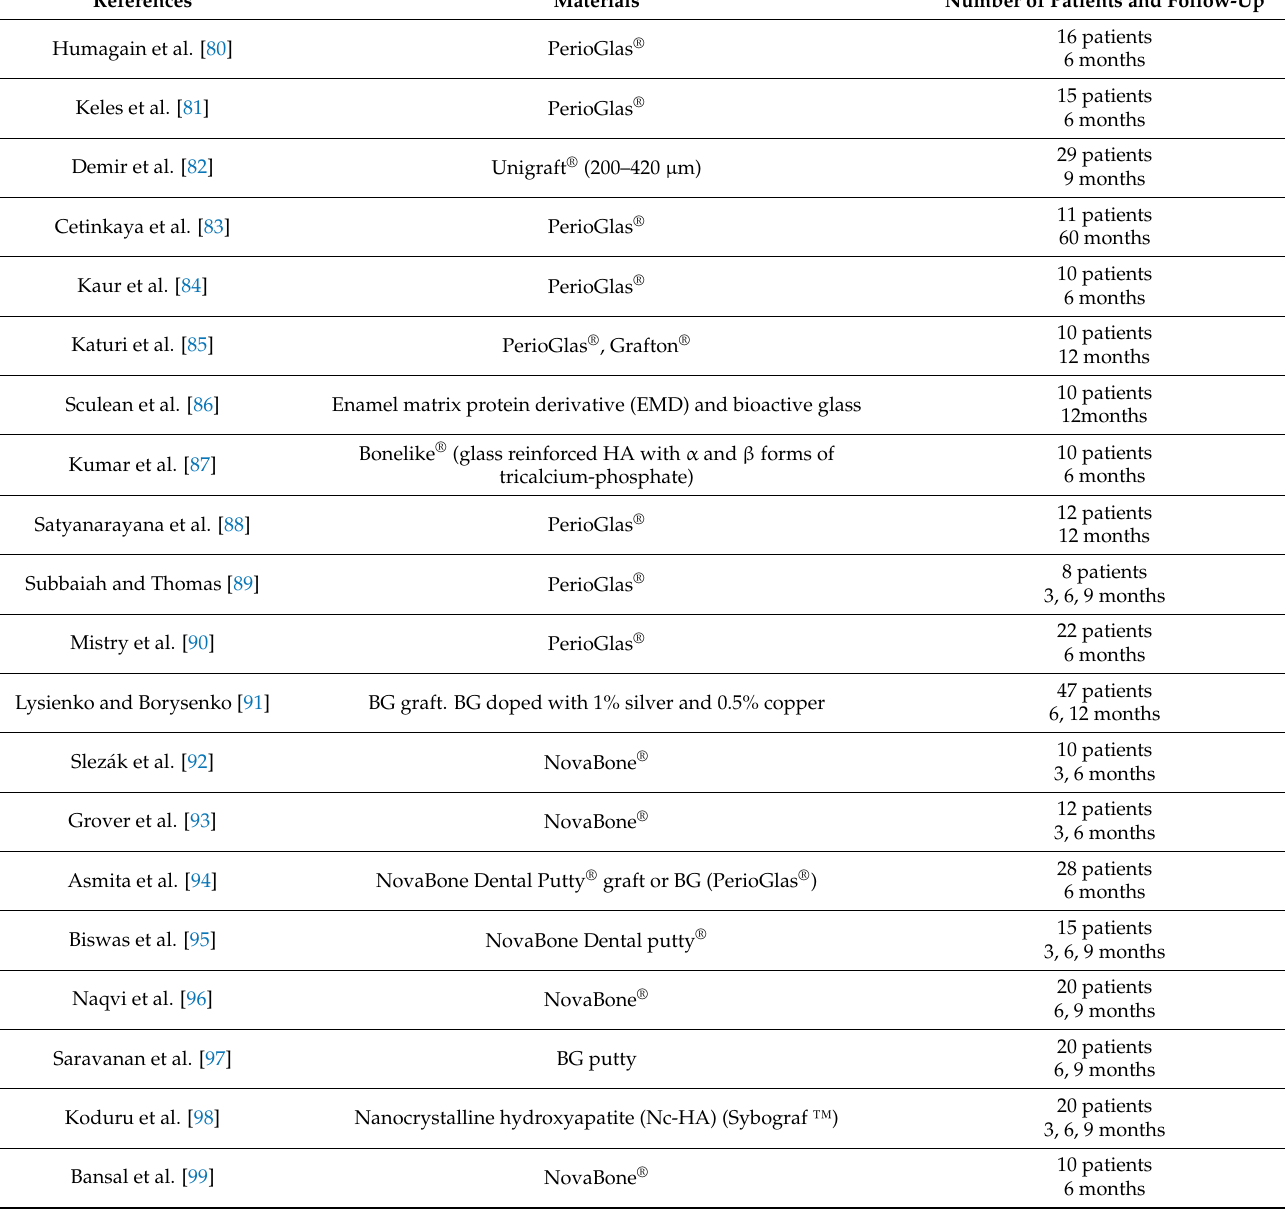
Table 3. Summary of clinical